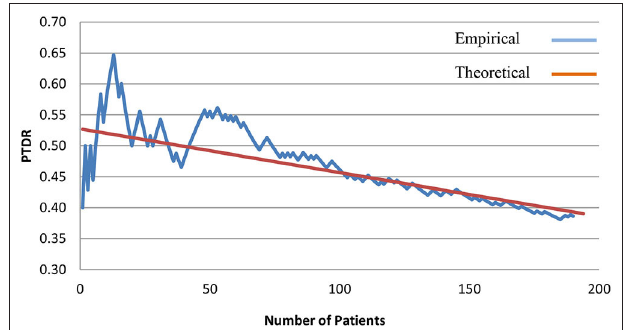
FIGURE 1 | The relationship between empirical and hypothetical PTDR from patient numbers.